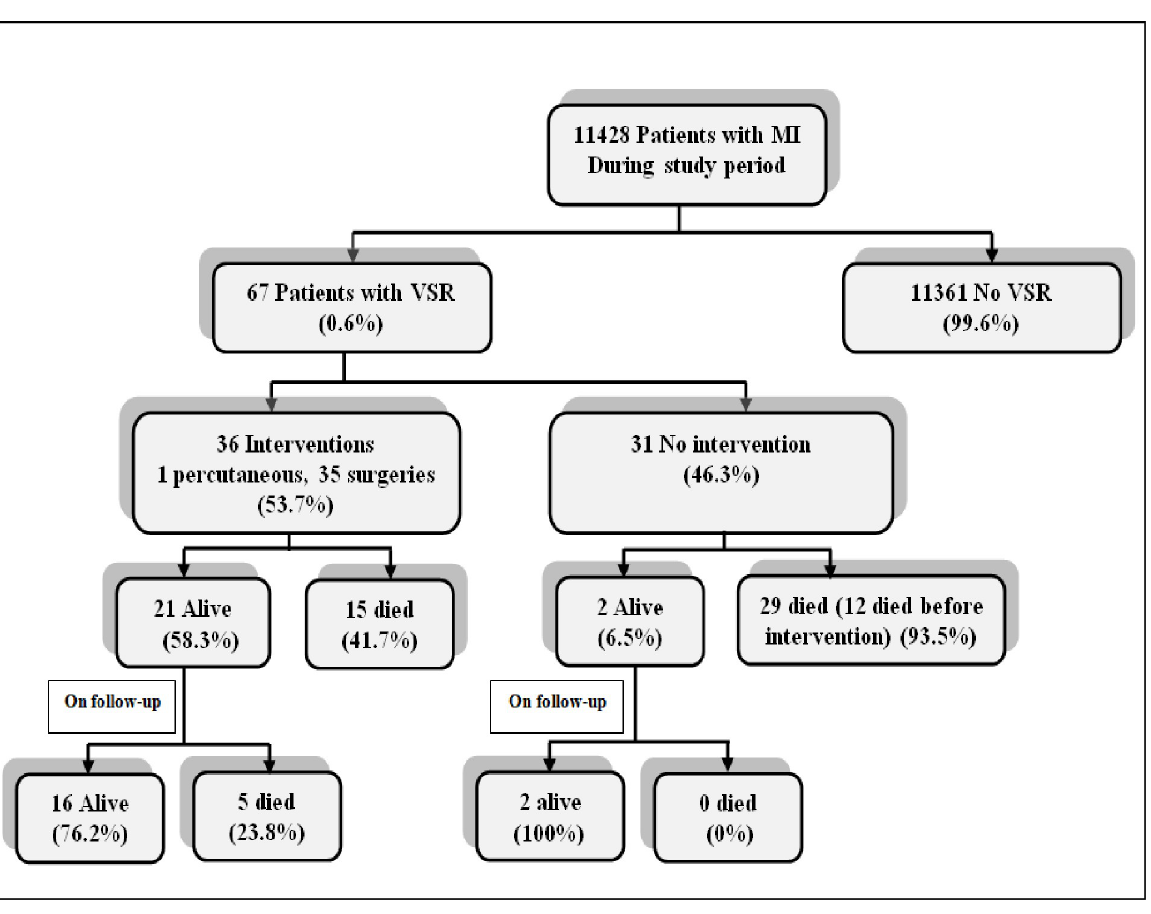
Fig 1. Flowchart of VSR